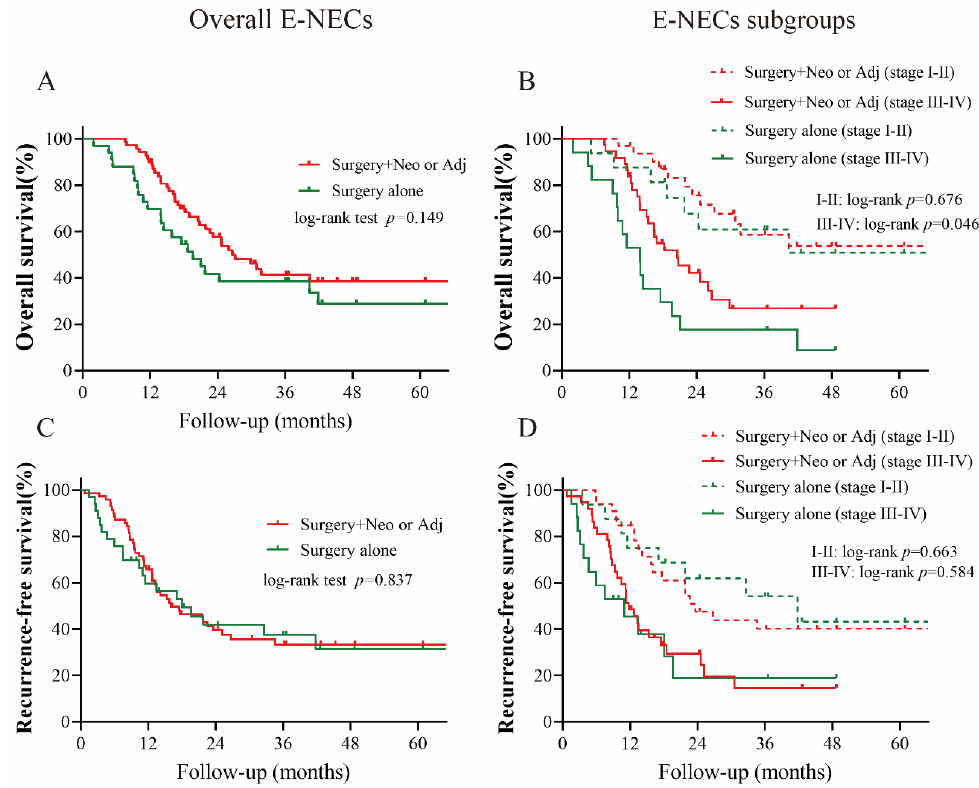
Figure 6. Comparisons of OS and RFS between subsets of E-NECs: ( A , C ) surgery alone vs. surgery combined with Neo or Adj in all E-NECs cases; ( B , D ) surgery alone vs. surgery combined with Neo or Adj in the stage I–II and III–IV subgroups. Abbreviations: E-NECs, esophageal neuroendocrine carcinomas; OS, overall survival; RFS, recurrence-free survival; Neo, neoadjuvant therapy; Adj, adjuvant therapy.